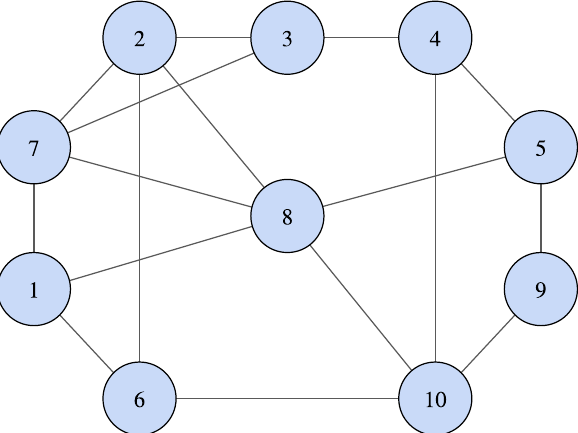
Figure 2. Graph G describing the communication network of the N = 10 agents. Figure 3 shows the consensus results for our protocol with a sampling period of ∆ = 10 − 4 and no event-triggered communication ( ε = 0 ) as an approximation of the ideal continuous-time case with full communication. For the Figures, we define ˆ z i ( t ) = ˆ z i [ k ] for t ∈ [ k ∆ , ( k + 1 ) ∆ ) . The desired dynamic average of the signals, ¯ z ( t ) , is plotted in a dashed red line. It can be observed that, after some time, the consensus error falls close to zero.